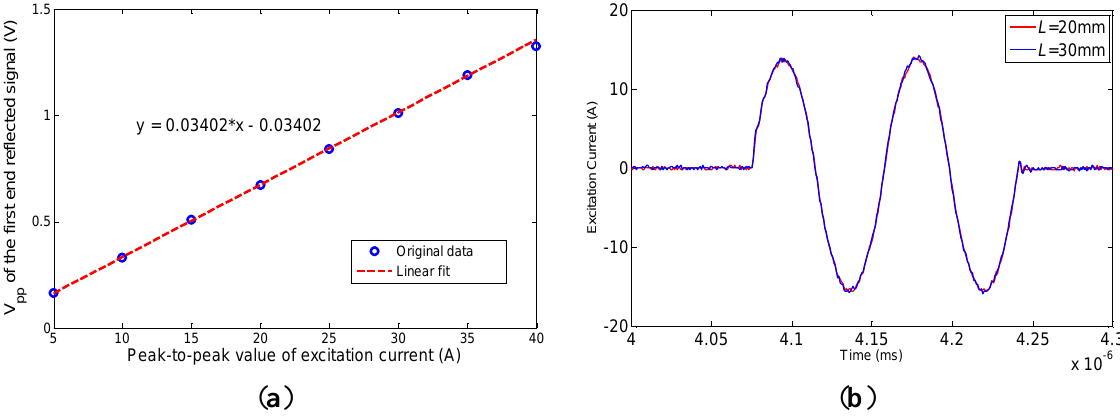
Figure 16. ( a ) The relationship between excitation current and the first reflected signal strength. ( b ) The typical excitation current signals with different L